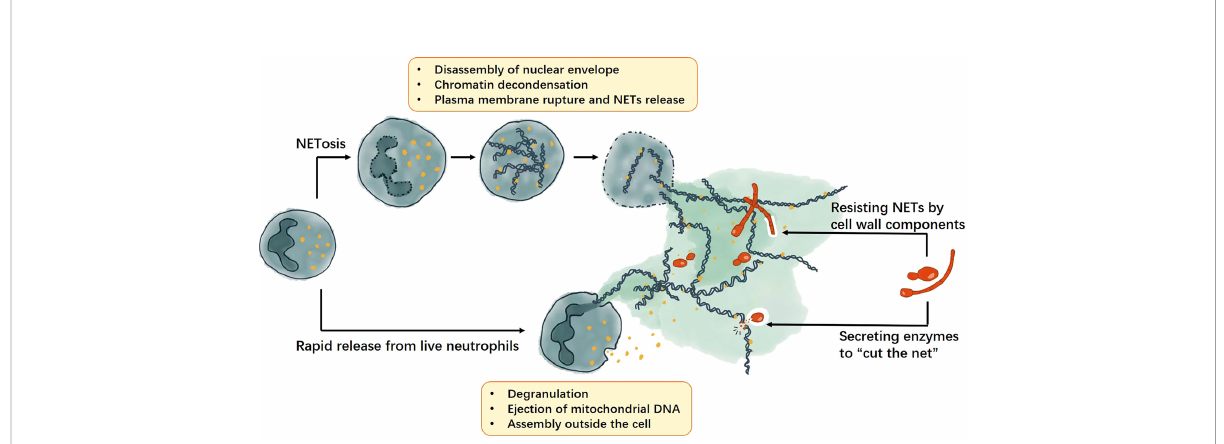
FIGURE 1 The formation of NETs and the fungal strategies against NETs. NETs can be produced though NETosis or rapid release from live cells. The NETosis process includes disassembly of nuclear envelope, chromatin decondensation, plasma membrane rupture and NETs release; whereas rapid release from live cells require cell degranulation and ejection of mitochondrial DNA, then the NETs will be assembled outside the cell. For fungi, they can resist NETs by cell wall components and secrete enzymes to help them escape the